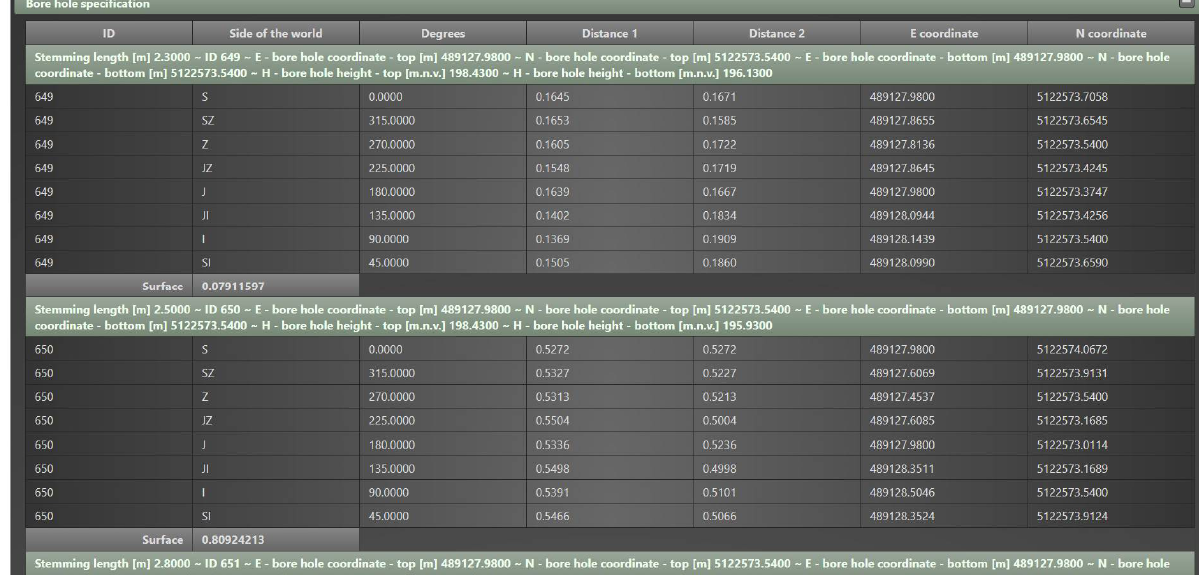
Figure 6. Separate layers belong to specific boreholes [4].